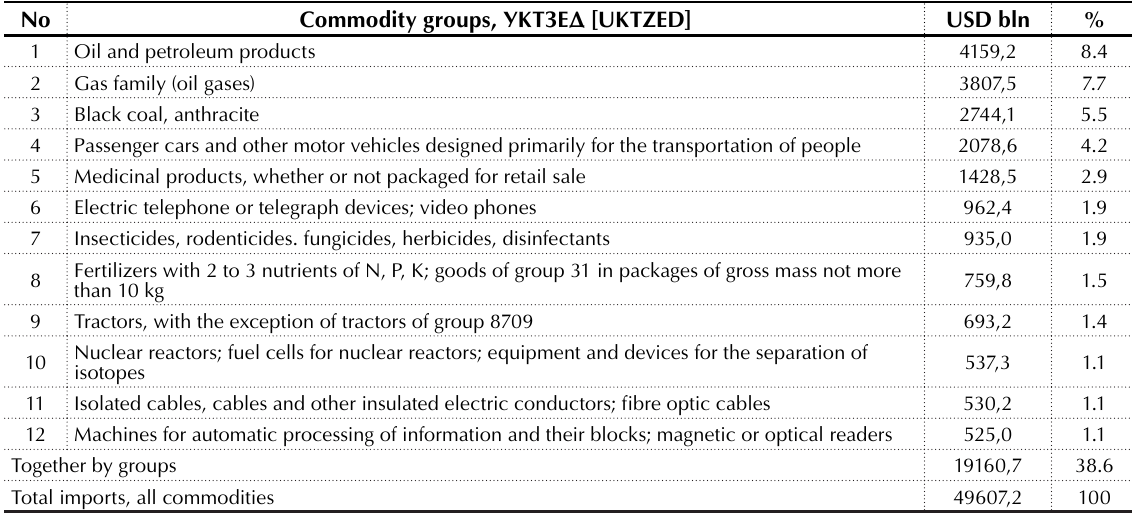
Table 3. Commodity groups with the largest share of imports into Ukraine in 2017